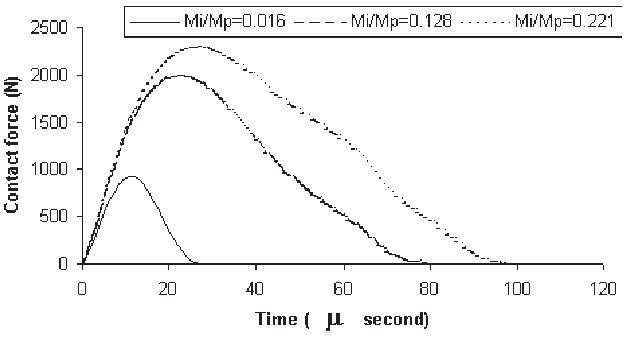
Fig. 14. Variation of adaptive contact force (point contact) on composite plate with respect to time for different Mi/Mp but fixed impact velocity.